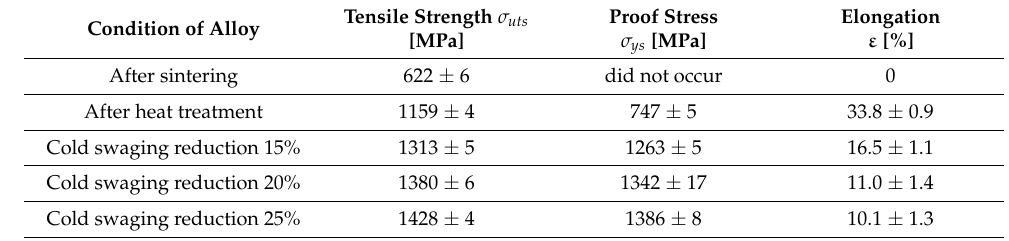
Table 2. WHA mechanical properties test results.